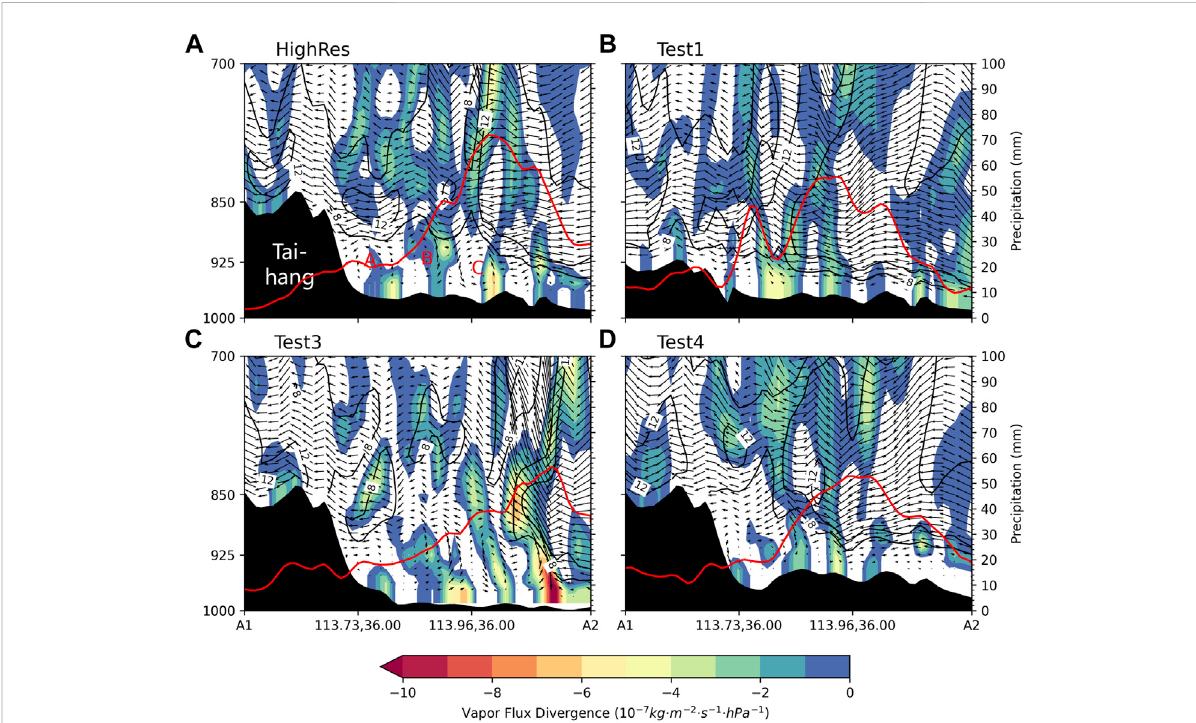
FIGURE 7 Vertical cross sections of the simulation experiment using the HighRes terrain (A) , Test1 (B) , Test3 (C) and Test4 (D) along the straight line between A1and A2 (asshown inFigure 6A)at0700 UTC on19 July 2016.The red line indicates thehourly precipitation (0700 – 0800UTC on 19 July 2016), and the wind vector is the combination of the U-wind component and the vertical velocity (W × 10). The black contour line indicates the U-wind speed exceeding 8 and 12 m/s. The shaded area indicates the vapor fl ux divergence (units: 10 − 7 · kg · m − 2 · s − 1 · hPa − 1